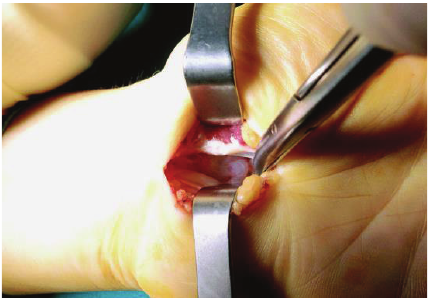
Figure 4: Intraoperative photograph shows the ganglion in the carpal